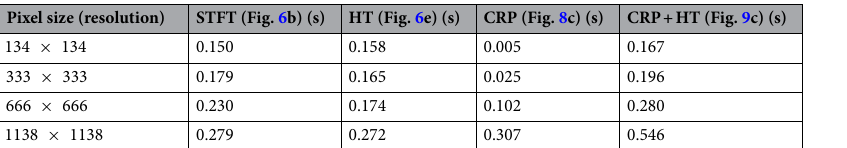
Table 1. Comparison of computation time.